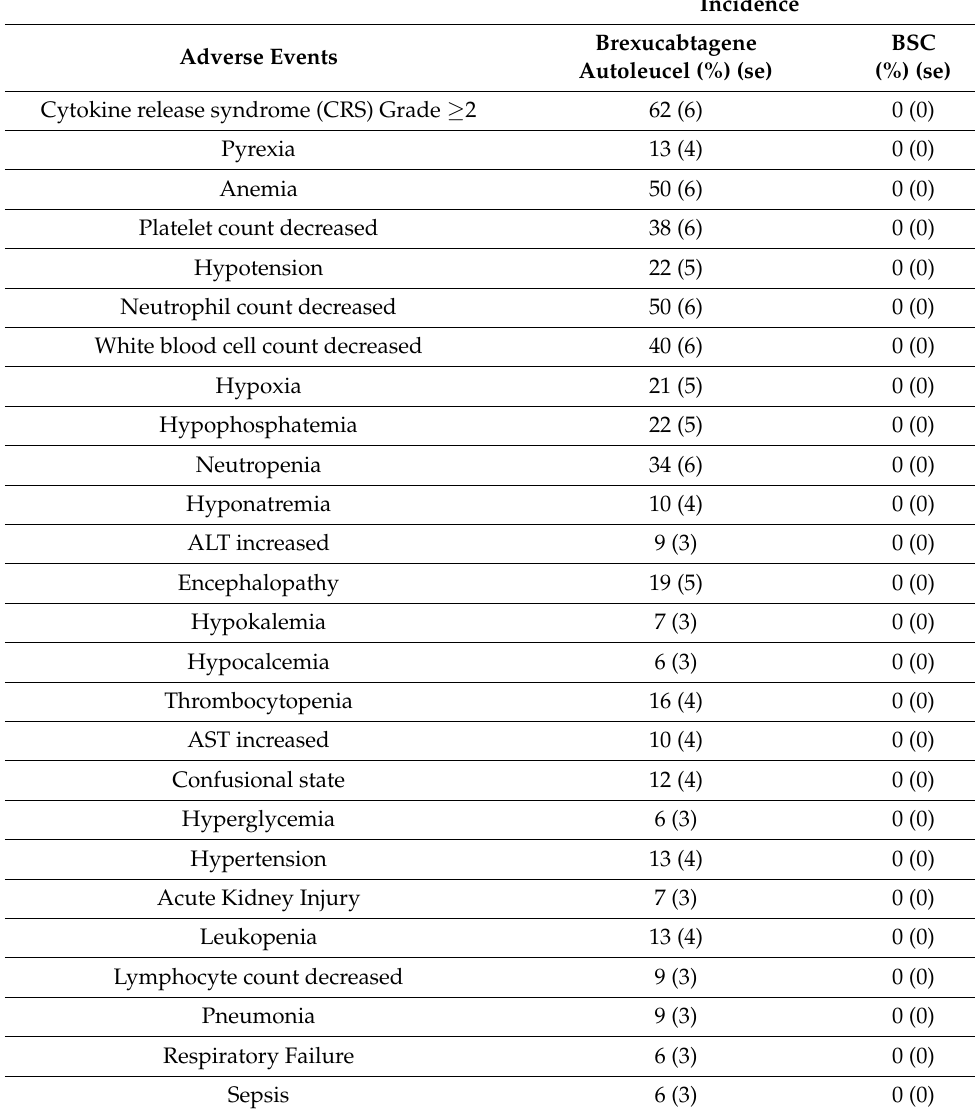
Table A6. Adverse event rates from ZUMA-2.